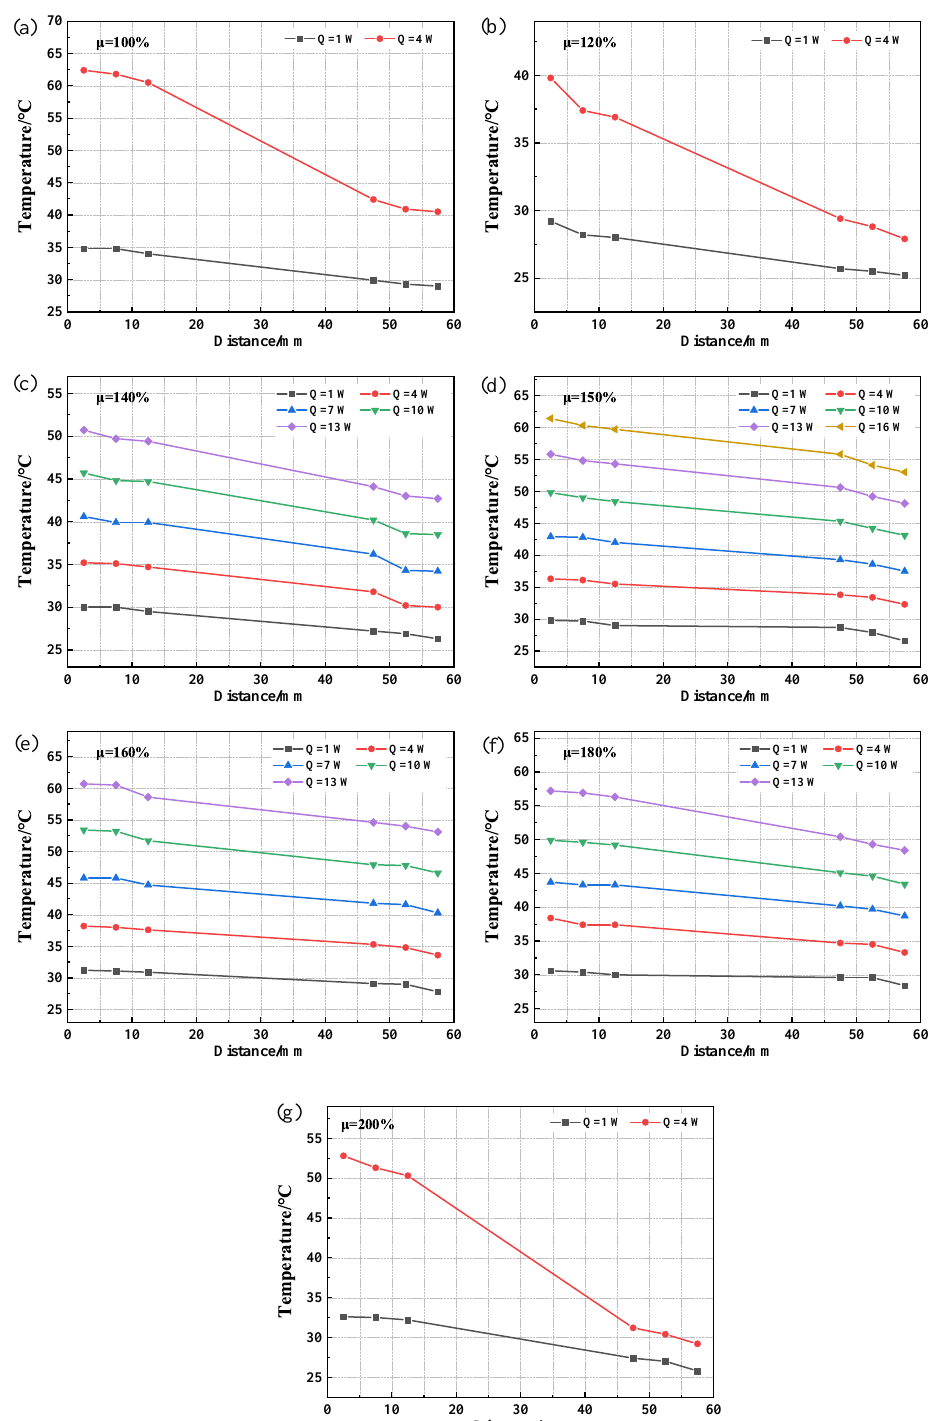
Figure 8. CW-FMHP axial temperature distribution at different thermal powers. ( a ) 100% filling rate; ( b ) 120% filling rate; ( c ) 140% filling rate; ( d ) 150% filling rate; ( e ) 160% filling rate; ( f ) 180% filling rate; ( g ) 200% filling